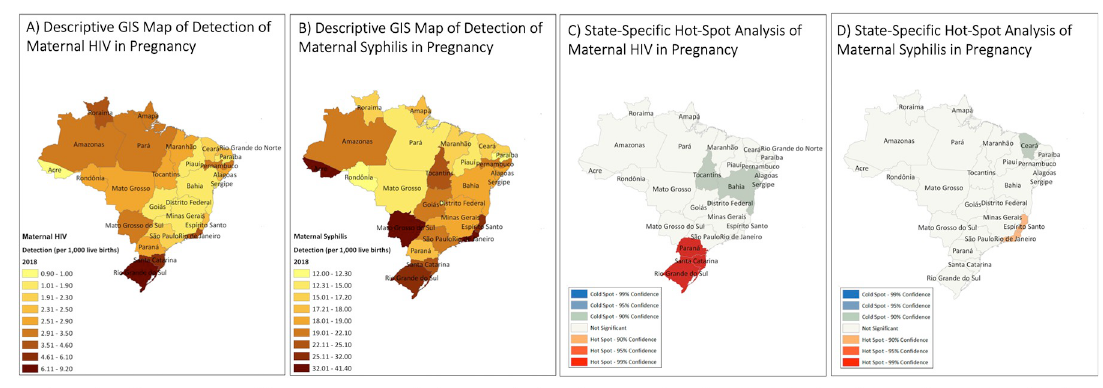
Fig 3. Spatiotemporal maps of the annual rate of detection of maternal HIV and syphilis among pregnant women in Brazil, 2018.